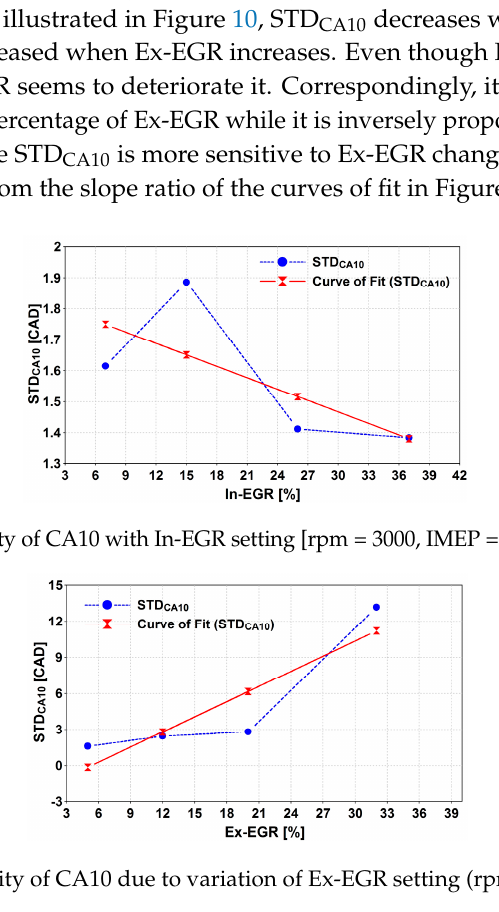
Figure 9. Cyclic variability of P max due to variation of Ex-EGR setting (rpm = 3000, IMEP = 2.1 bar, T epc = 425–530 K).